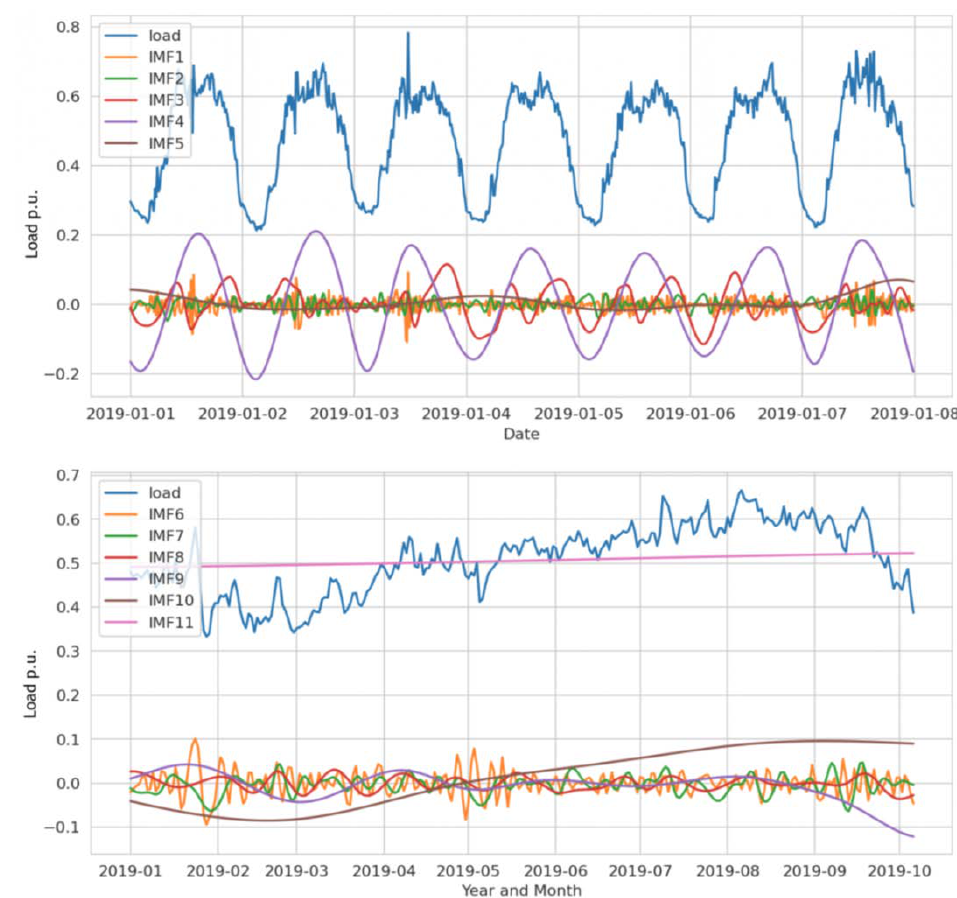
Figure 9. EMD performed on the Hotel 1 load which produced 11 IMFs. This image should be viewed in color for